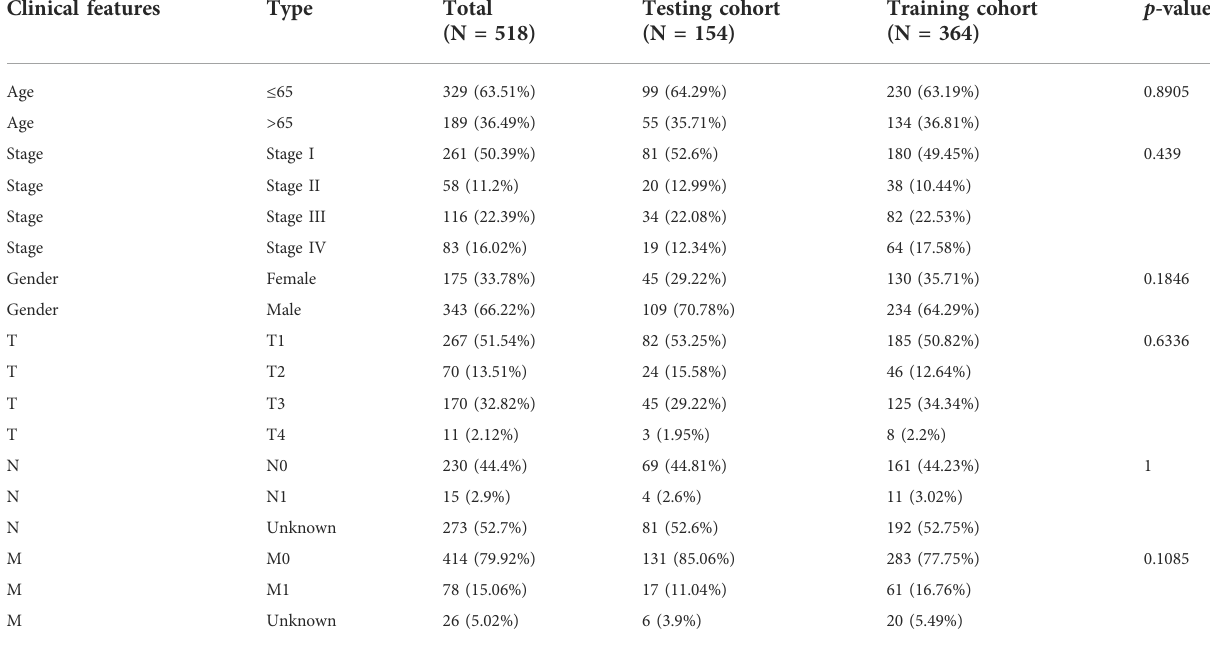
TABLE 1 Characteristics of training, testing, and total